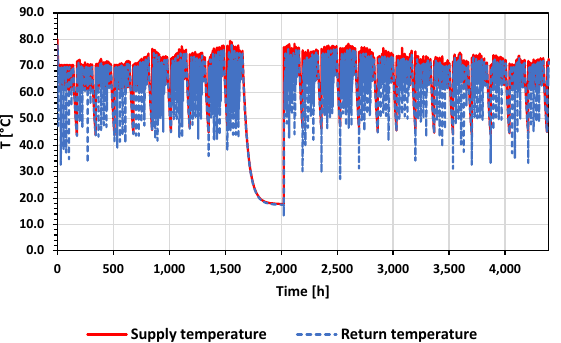
Figure 11. Optimised scenario – Central heating system along the entire heating season [h]: supply (red) and return (blue) temperature [°C].